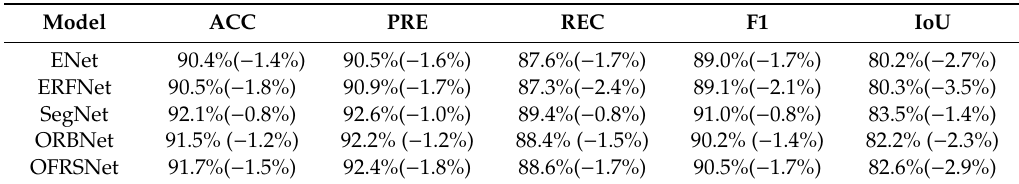
Table 3. Evaluation results of models trained with cross-entropy loss (CE). The values in parentheses are the metrics degradation compared to that when models were trained with spatially-weighted cross-entropy loss